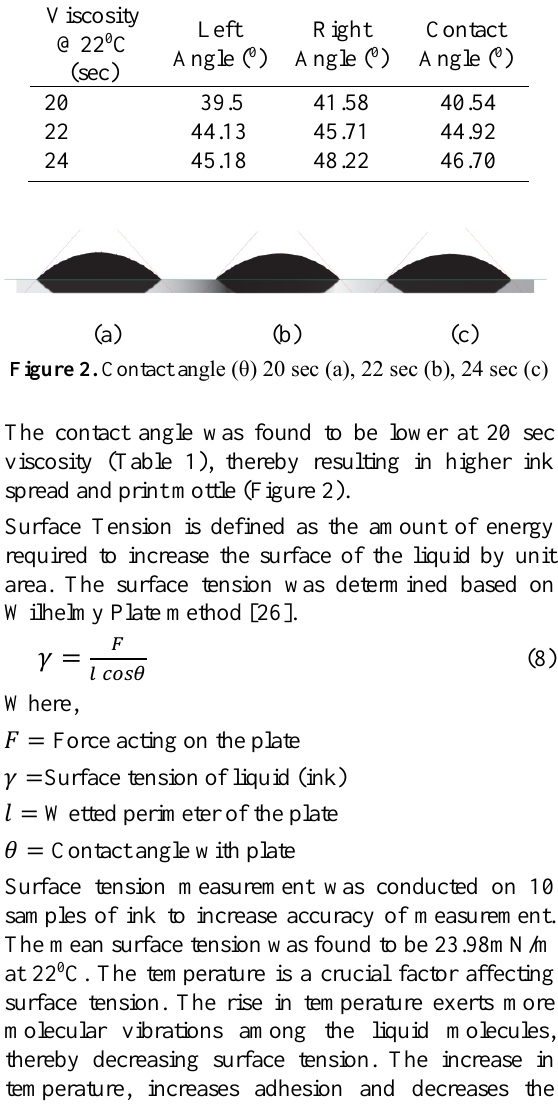
Table 1. Contact angle measurement